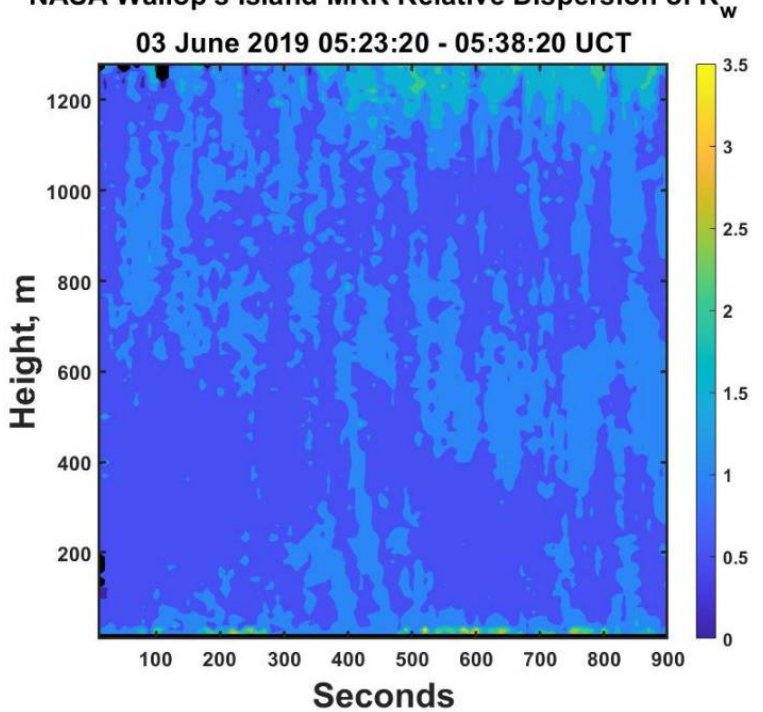
Figure 8. The time–height plot of the relative dispersion = σ Rw /R w corresponding to Figure 7. Note that in this instance, throughout most of the domain the relative dispersion is unity or smaller.